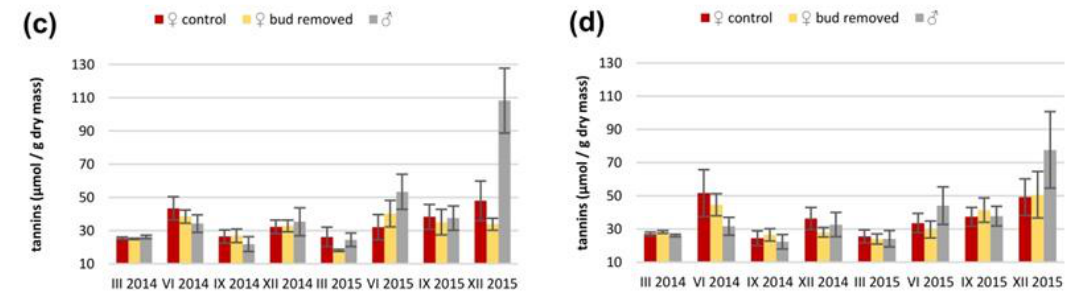
Figure 3. Mean values ( ± standard error) of ( a , b ) concentrations of phenolic compounds and ( c , d ) tannins in ( a , c ) current-year increments and ( b , d ) 1-year-old increments in control and bud-removed Taxus baccata shoots of females and in male shoots measured in different seasons for two years.